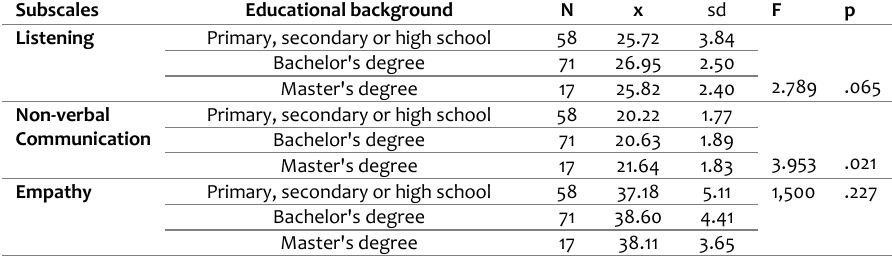
Table 4. The Parent-Child Communication Assessment Tool (PCCAT) ANOVA Test Results regarding the Subscale Scores for the Educational Background of the Father Subscales